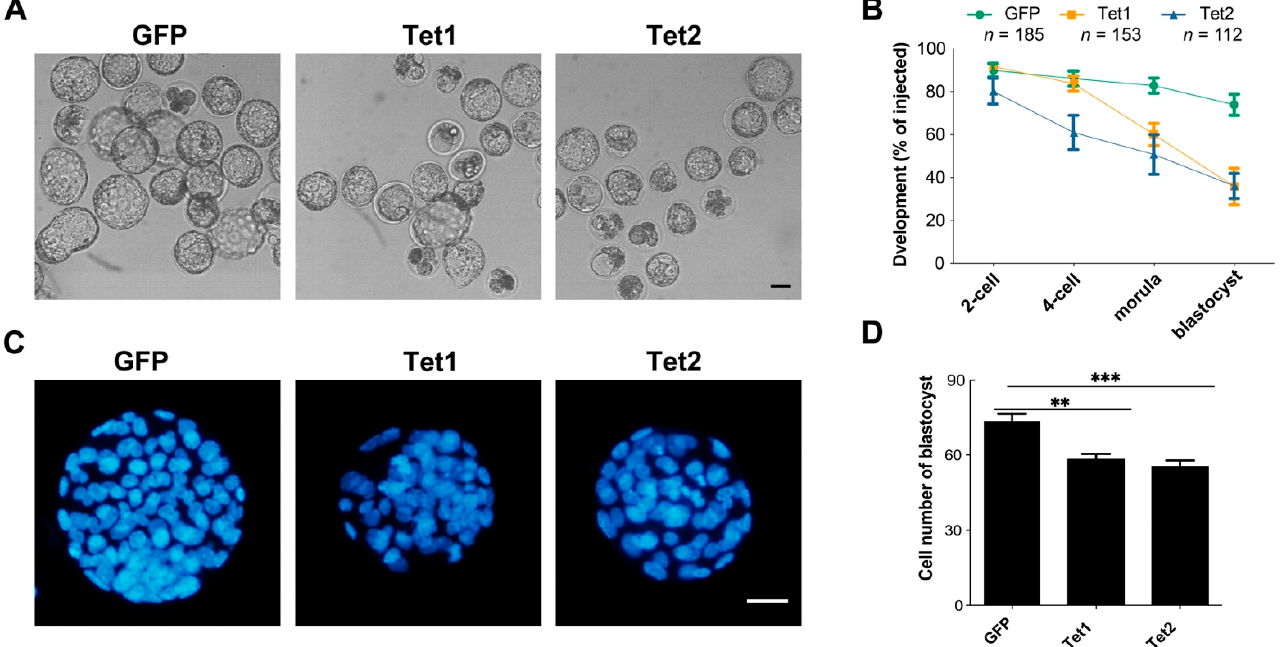
Figure 6. The effect of overexpression of Tet1 and Tet2 on embryonic development. ( A ) The blastocysts developed from zygotes injected with GFP, Tet1, or Tet2 mRNA. ( B ) Preimplantation development rates of the injected zygotes. ( C ) Representatives of blastocytes stained with DAPI for labeling the cells. ( D ) Statistical analysis of total cell number in blastocysts. The number of stained blastocysts in each group was more than 25. Scale bar = 100 μ m. “**”, p < 0.001; “***”, p < 0.0001.